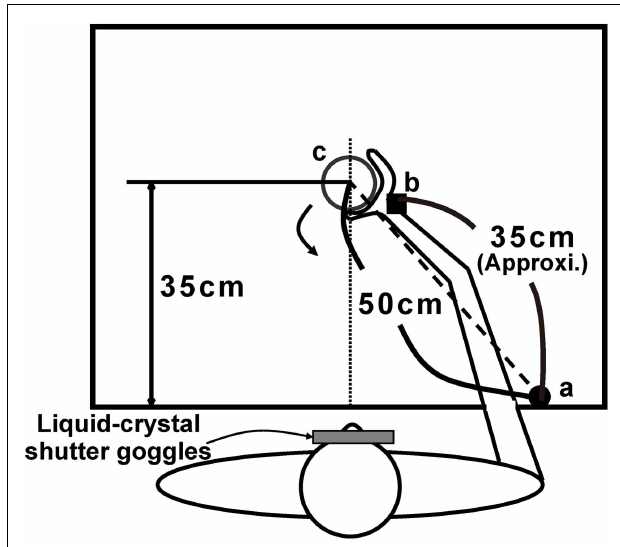
FIGURE 1 |Table layout for the experiment. a: Initial hand position on the pressure-sensitive switch; b: position of cubical receiver on the wrist when grasping; c: position of target presentation.The reaching distance recorded by the receiver was approximately 35cm from the starting